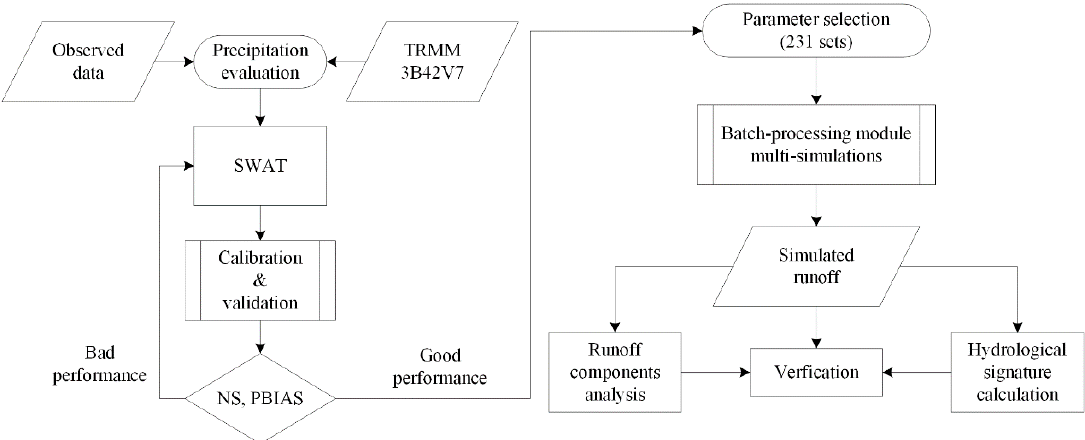
Figure 2. Framework of this study.